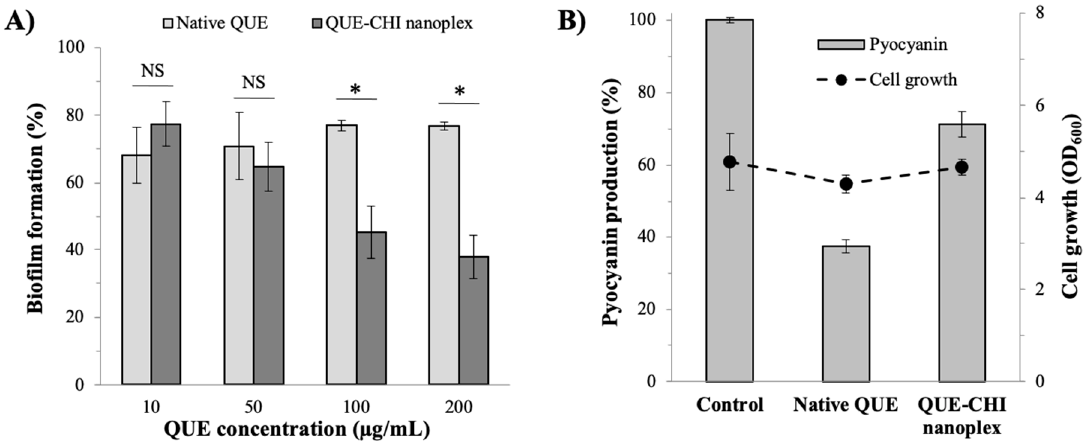
Figure 9. ( A ) Rate of biofilm formation and ( B ) pyocyanin production in the presence of QUE (NS = not statistically significant, * p ≤ 0.05) .